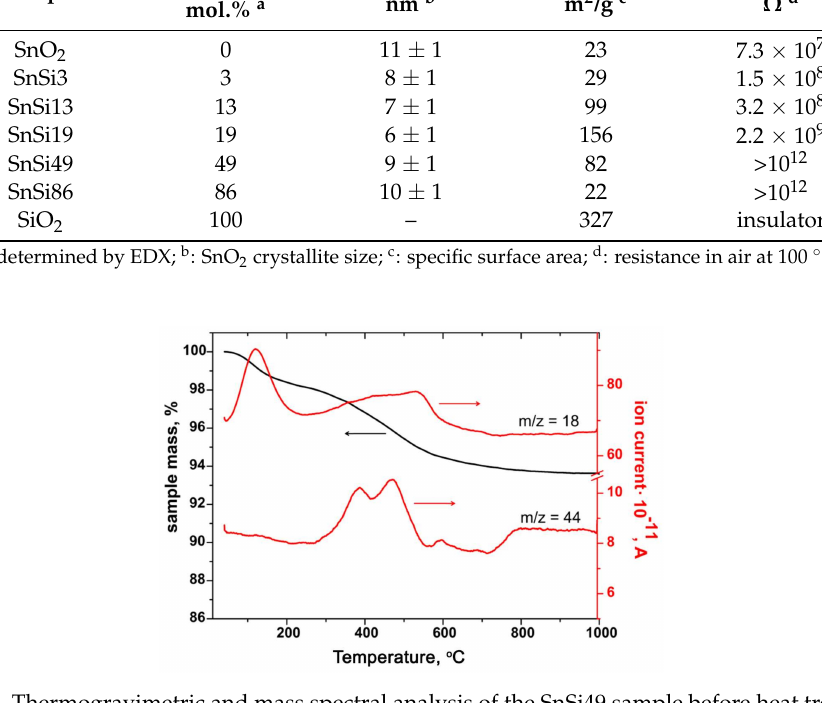
Figure 1. Thermogravimetric and mass spectral analysis of the SnSi49 sample before heat